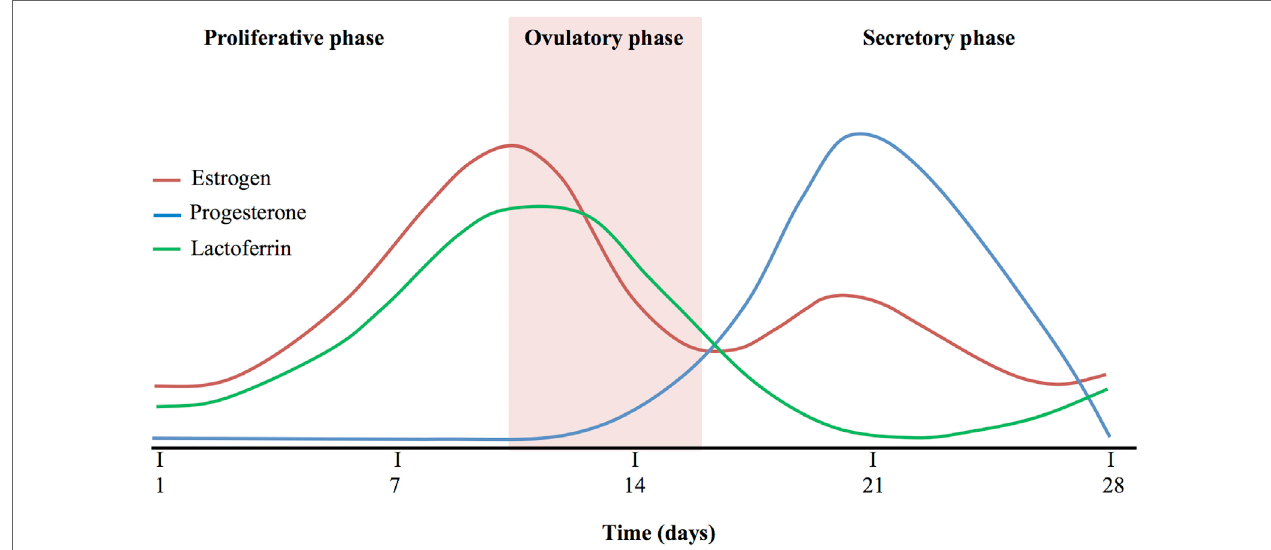
FiGURe 1 | Comparison among estrogen, progesterone, and Lactoferrin